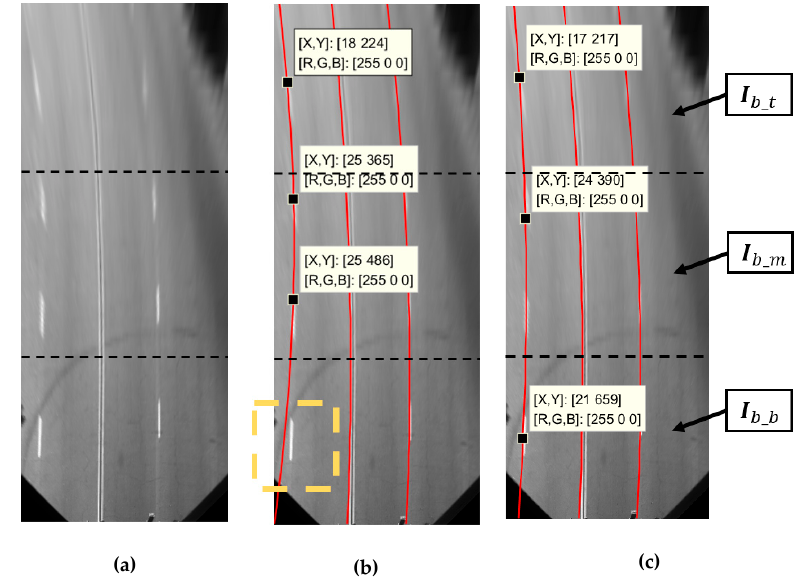
Figure 9. Regional fitting points selection illustration. ( a ) Aerial map. ( b ) Select. fitting points randomly from whole map. ( c ) Select fitting points randomly from three areas.